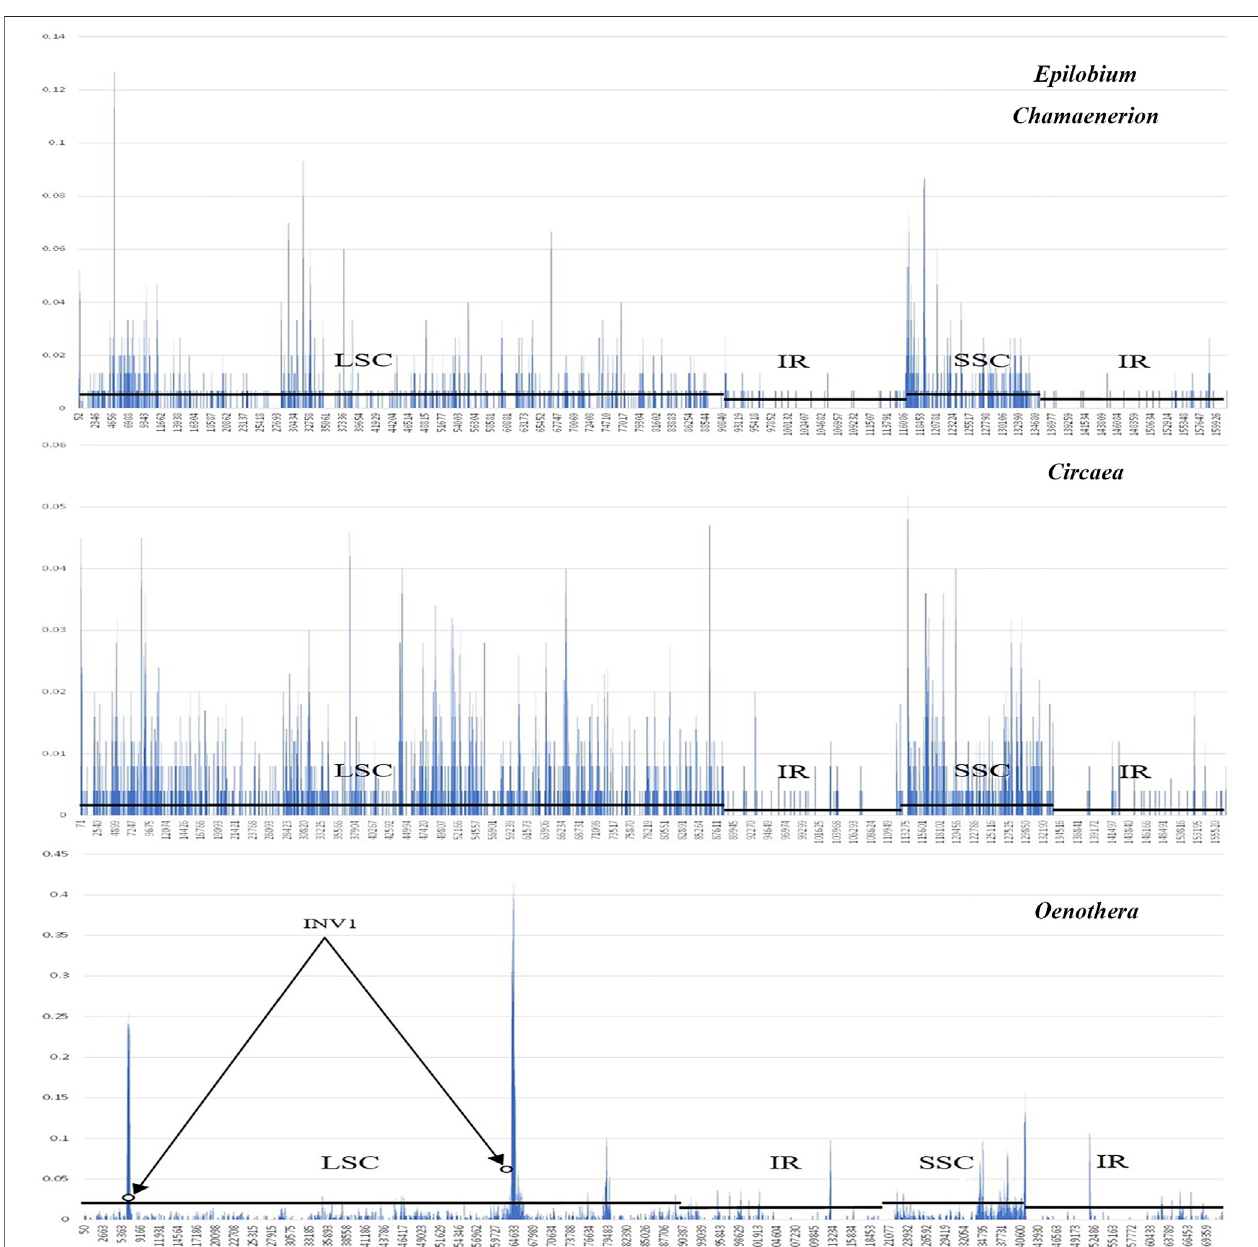
FIGURE 4 | A sliding window analysis of the complete chloroplast genomes of Epilobium , Chamaenerion , Circaea , and Oenothera samples showing nulceotide variability (Pi)withineach genus. Circles identifythe regions bordering inversion sitesof Oenothera , and lines parallel tothe X -axis identify thepositionsofLSC, SSC,and IR